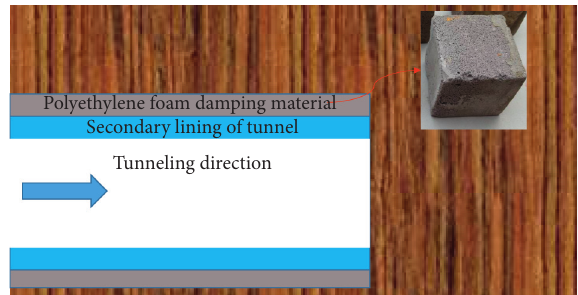
Figure 10: Arrangement of polyethylene foam vibration damping material in the tunnel.